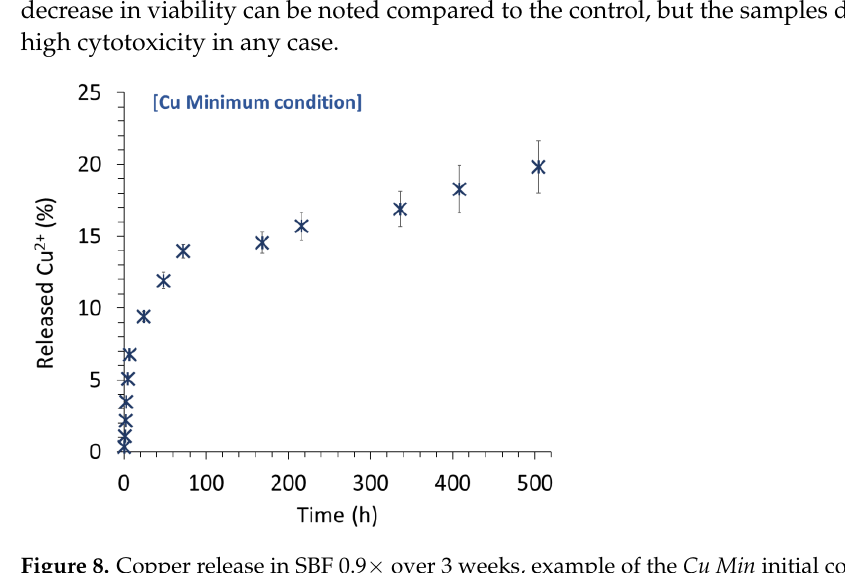
Figure 8. Copper release in SBF 0.9× over 3 weeks, example of the Cu Min initial concentration.